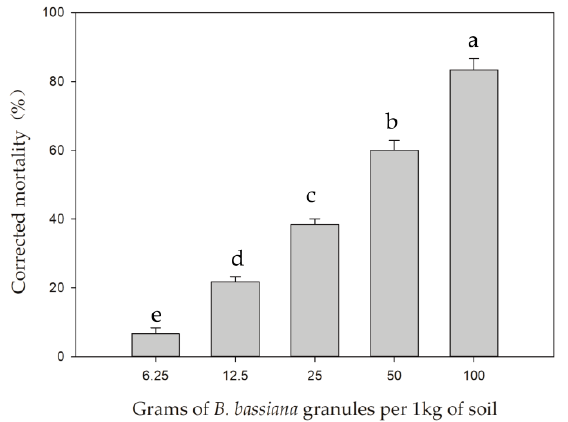
Figure 1. Effect of different concentrations of Beauveria bassiana granules on the mortality of soil-dwelling pupae of Western Flower Thrips, Frankliniella occidentalis . Columns marked with different letters are significantly different from one another. Bars above columns denote standard errors of the means.